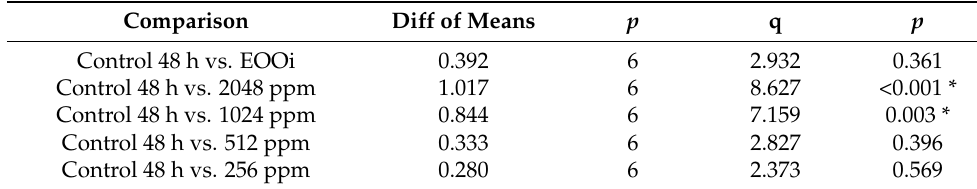
Table 7. One-way ANOVA between A. parasiticus colonies after 48 h of incubation with the EO and the NE.